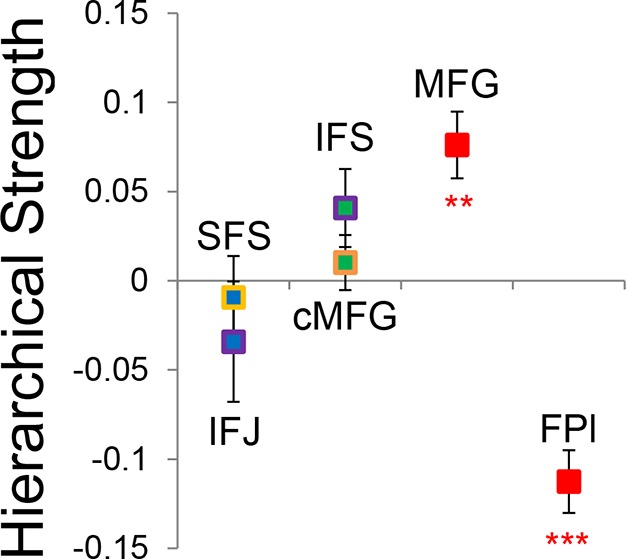
Hierarchical structural dependencies.Based on fixed connectivity of the model depicted in Figure 6A, hierarchical strength was calculated as the difference between inward and outward projections along the rostral/caudal axis. Hierarchical strength rose monotonically from caudal to mid areas, but fell precipitously at the rostral most portion of the network. **pcorrected<0.005; ***pcorrected<0.0005.